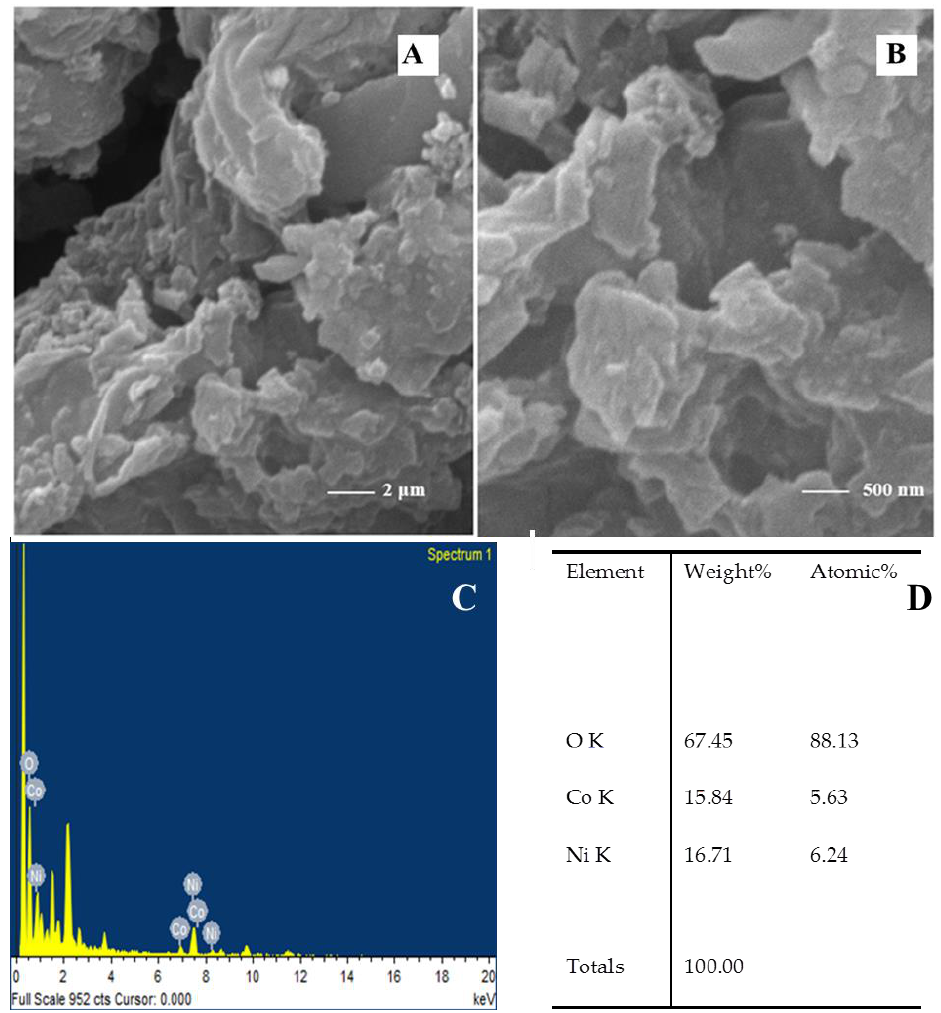
Figure 2. ( A,B ) SEM analysis, ( C ) EDS analysis, and ( D ) percentage of elements in NiCo(OH) 2 -LDH powdered sample.